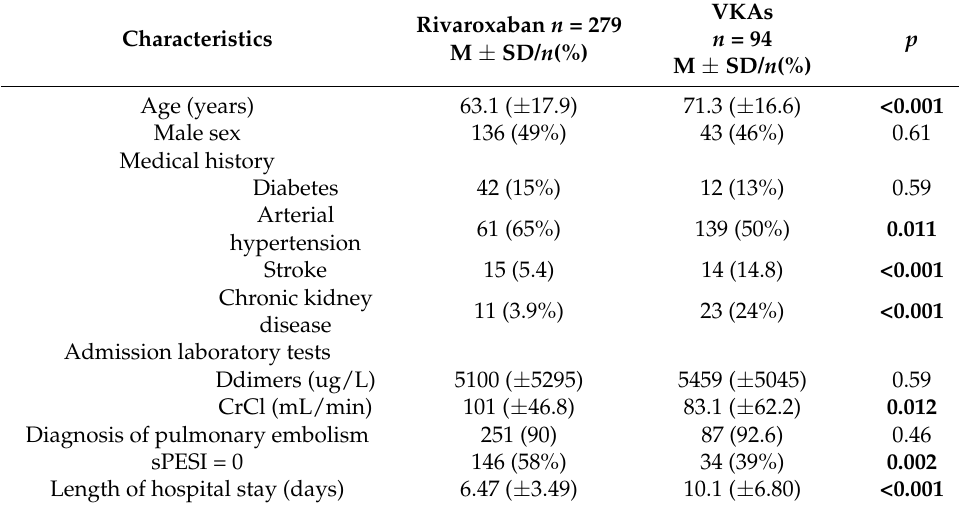
Table 1. Patients’ characteristics at